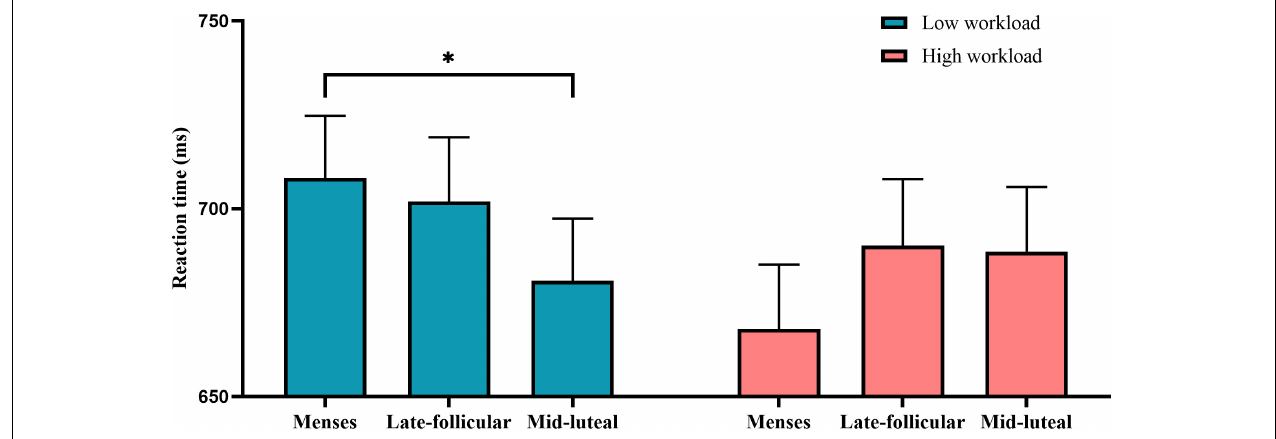
FIGURE 5 | The interactive effect of workload and the menstrual cycle on the reaction time measure of the divided attention task. Error bars represent the standard error of the mean. ∗ indicates p < 0.05.